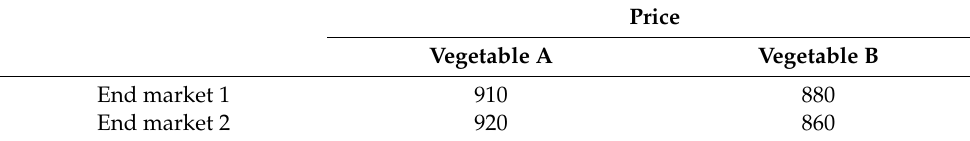
Table 3. Selling price of vegetables.